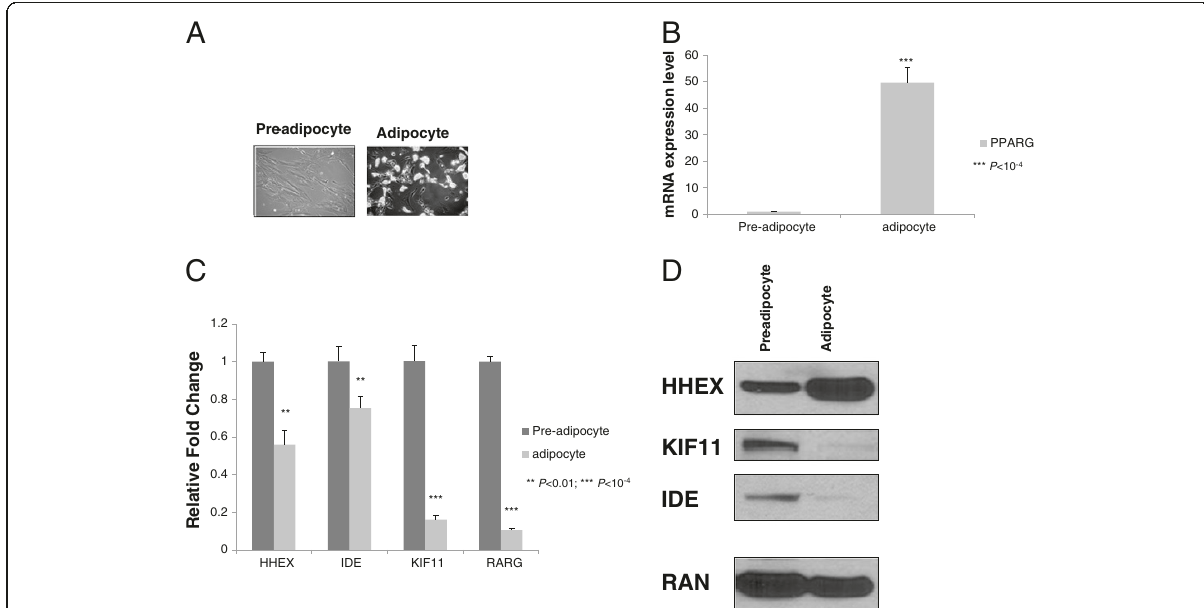
Figure 1 Expression of the three genes within the 10q23 locus at both the pre-adipocyte and adipocyte stage of SGBS cell differentiation. mRNA and protein were extracted from SGBS cells either at the pre-adipocyte or adipocyte stage cultured in differentiation medium supplemented with Troglitazone for 27 – 49 days. Confocal image of SGBS cells in the pre-adipocyte and adipocyte states (49 days in differentiation medium) are shown ( A ). In ( B ) change in real-time PCR normalized for 36B4 mRNA expression levels of the PPARG control before and after differentiation; as expected, PPARG levels increase. In ( C ), change in real-time PCR normalized for 36B4 mRNA expression levels in HHEX , IDE, and KIF11 mRNA expression levels; the levels of the RARG control decrease as expected. Western blots ( D ) were carried out to measure either mRNA and protein levels of the genes of interest, respectively. Standard deviations were calculated based on four independent mRNA replicates. A representative Western blot result is